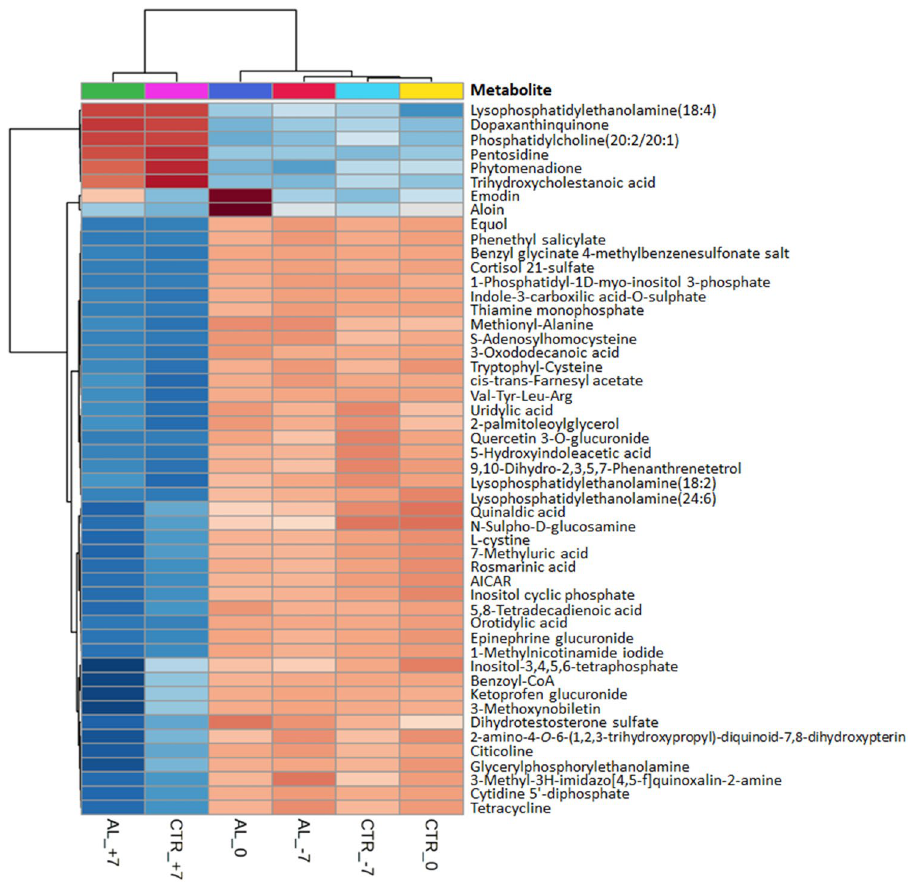
Figure 3. Heatmap with hierarchical cluster analysis showing the longitudinal changes in the plasma metabolome profile across sampling day ( ‒ 7, 0, and 7 days from dry-off) and dietary treatment (lyophilized A. arborescens supplementation [AL] or control diet [CTR]). Groups at each sampling day are represented in the columns. The top 50 metabolites were ranked by the P -value of one-way ANOVA and represented in the lines. Data were auto-scaled by